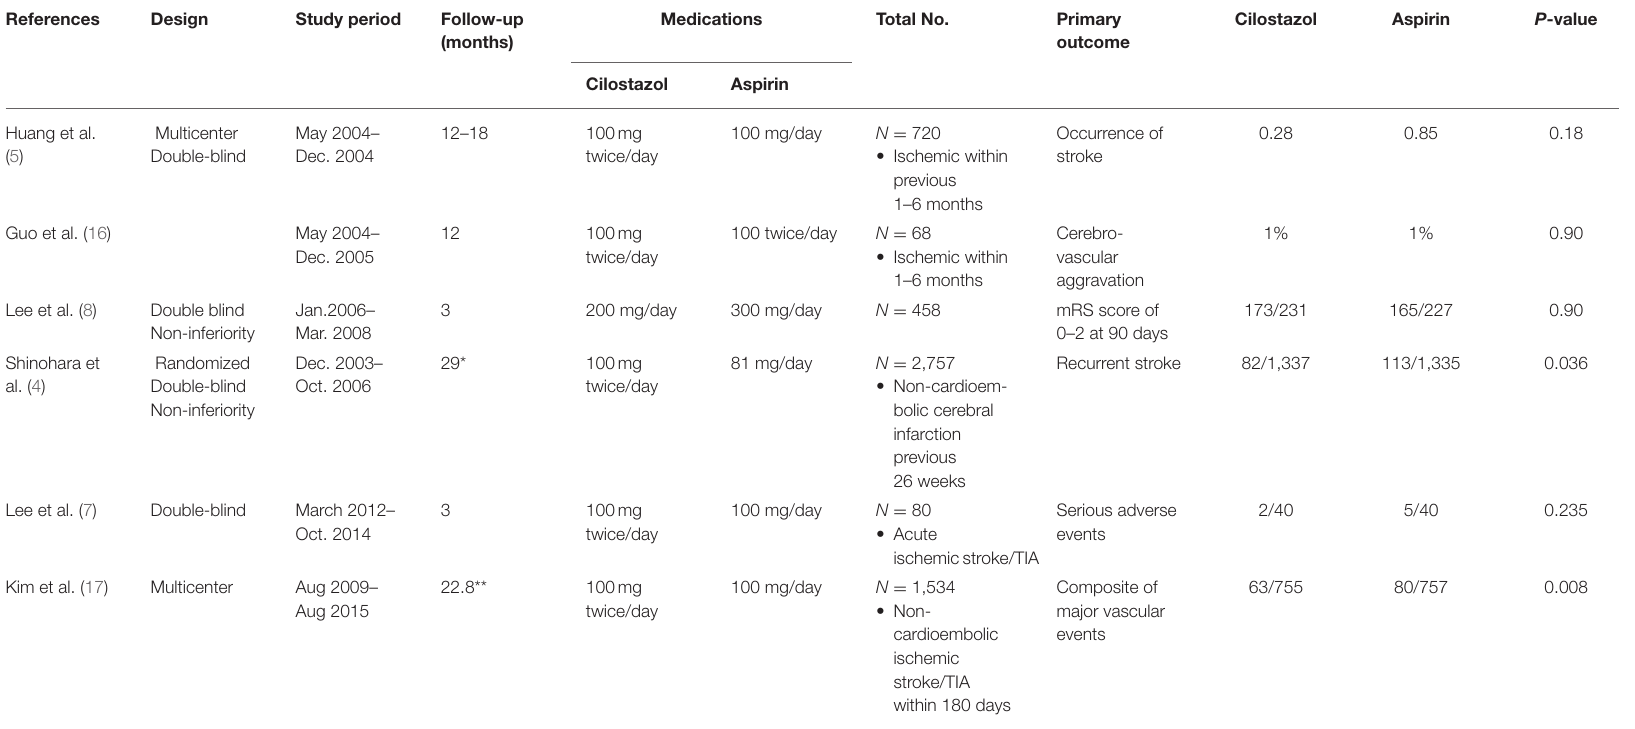
TABLE 1 | Characteristics of included